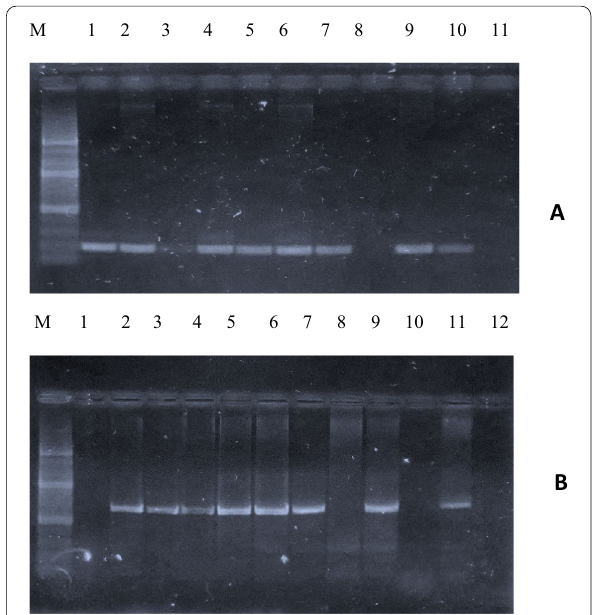
Fig. 2 DNA electrophoresis of PCR amplicons for patients with PCOS and control. A shows DNA amplification using primer AR1 in lanes 1, 2 4, 5, and AR3 in lanes 6 and 7. Lanes 9 and 10 amplicons from control group and empty lanes are negative controls. B shows DNA amplification using primer AR2 in lanes 2, 3, 4, and AR4 in lanes 5, 6, and 7. Lanes 9 and 11 amplicons from control group and empty lanes are negative controls. M is 100 bp DNA marker